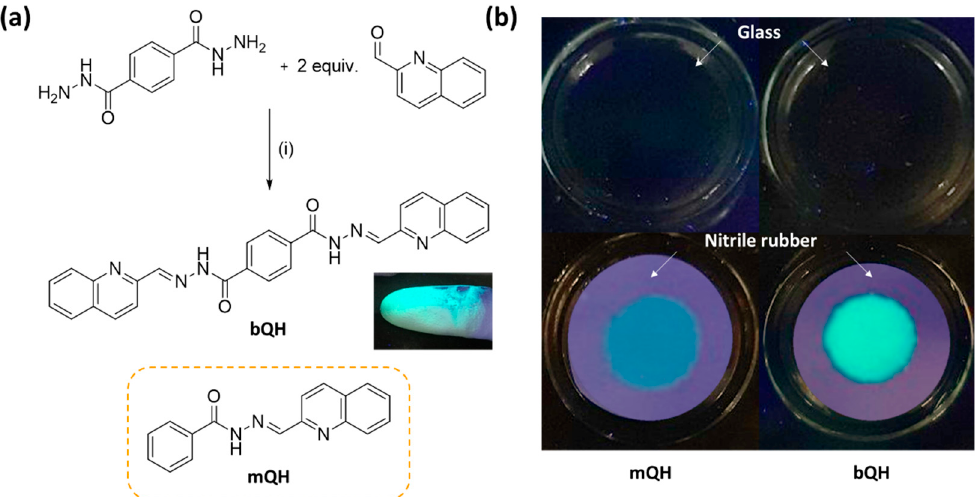
Figure 1. ( a ) Synthesis of bis -quinoline-based acylhydrazone (bQH) and the structure of mono-quinoline acyl hydrazone (mQH). Reaction conditions: (i) Few drops of AcOH, MeOH, rt, 8 h, 88%. Inset: Emission of bOH on nitrile rubber gloves under 365 nm ultraviolet (UV) lamp. ( b ) Images of bQH and mQH (2.5 × 10 − 4 M in dimethyl sulfoxide (DMSO), 20 µ L) dropcasted on glass (upper) and nitrile rubber (bottom), under 365 nm UV lamp.